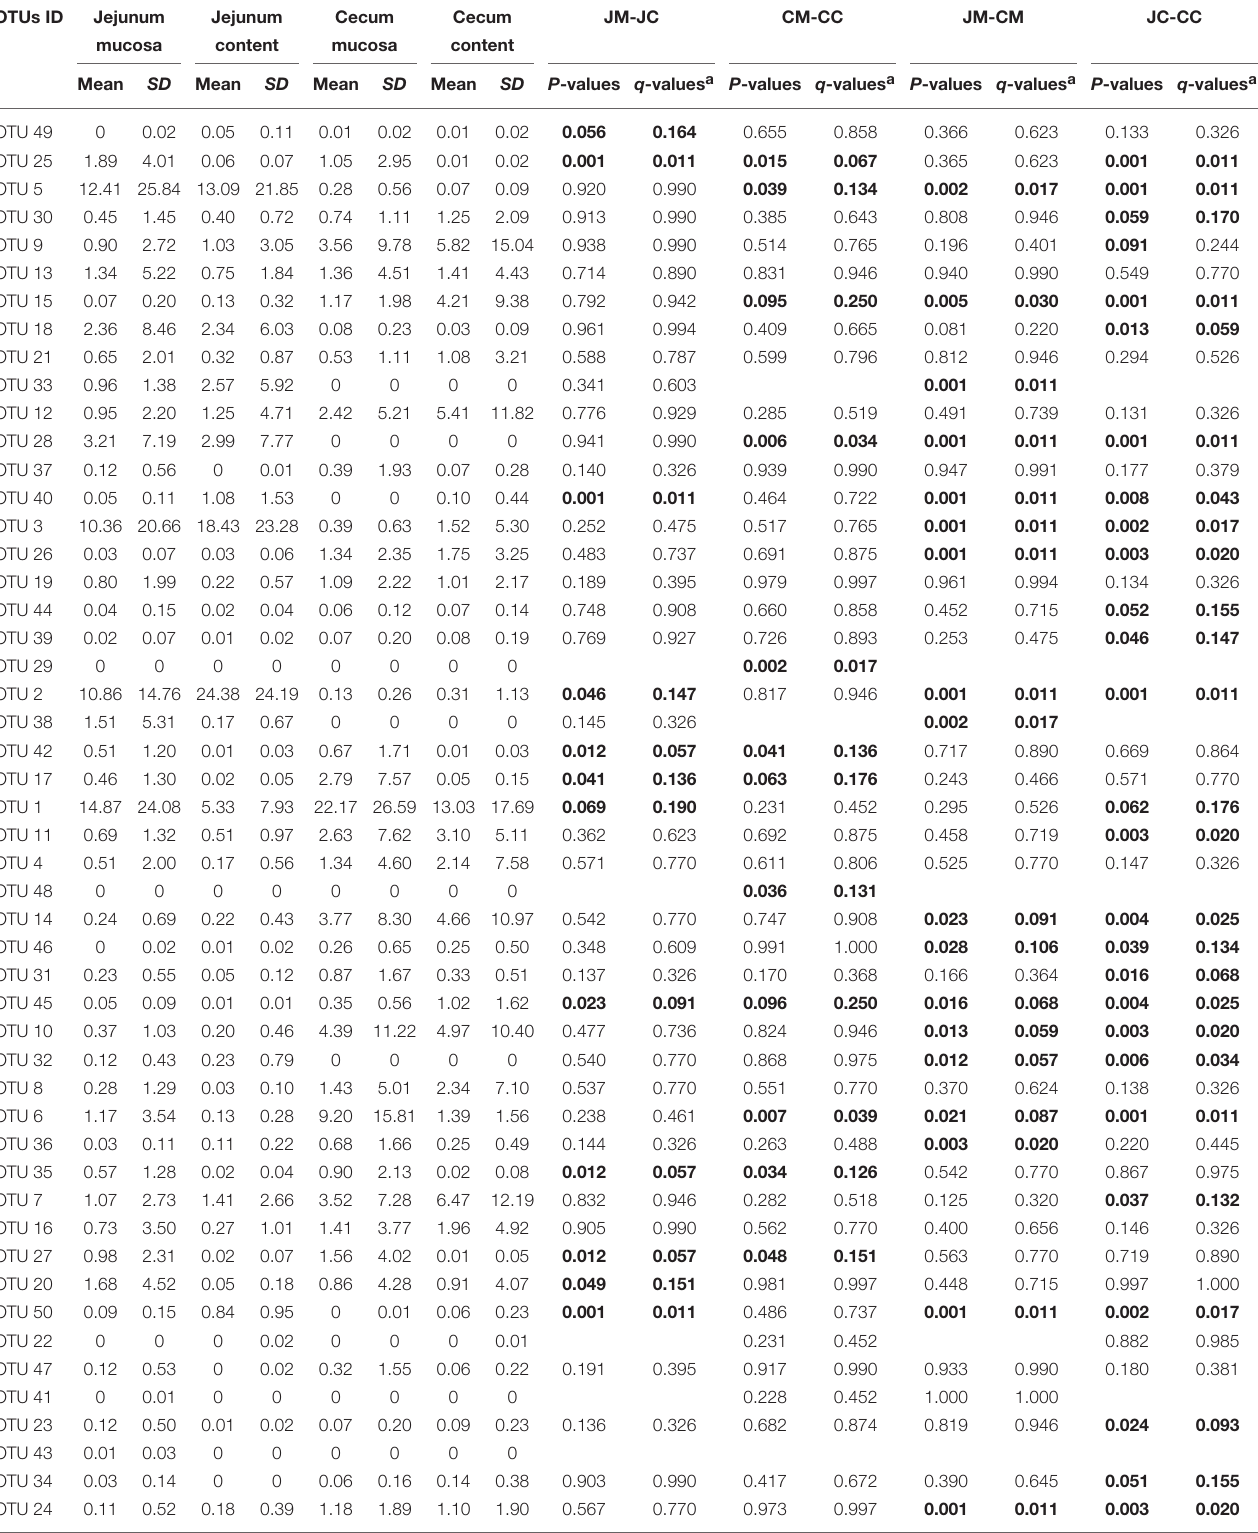
TABLE 2 | Relative abundances (%) of the most abundant OTUs in different gut sites of control birds (day 1–28). OTUs